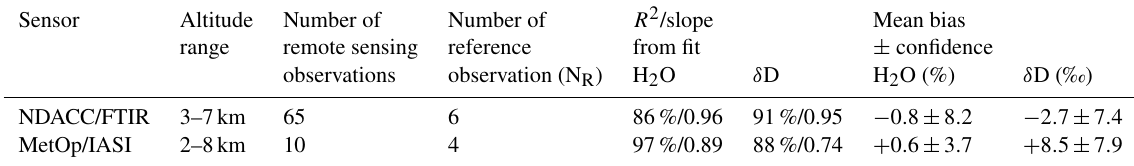
Table 1. Empirical validation and bias assessment of the NDACC/FTIR H 2 O and δ D products in the lower troposphere. Sensor Altitude Number of Number of R 2 /slope Mean bias range remote sensing reference from fit ± confidence observations observation (N R )